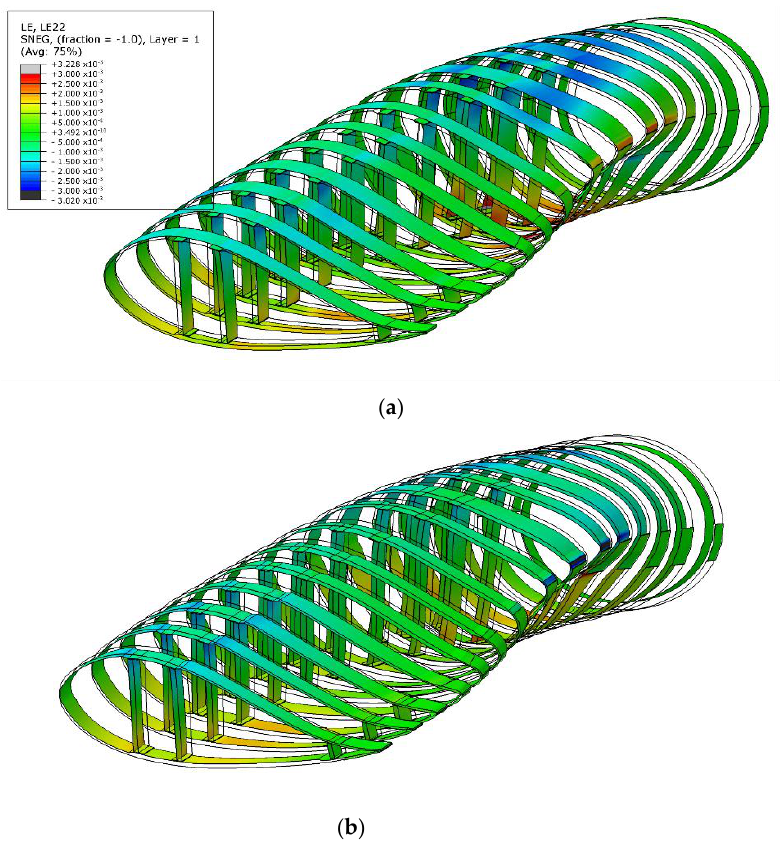
Figure 16. Contour plots of the transverse true strain values on a series of cross-sections of the solid model, deformed under the negative flatwise load case. The deformation is scaled by a factor 20 for clarity. ( a ) Strain values on the outside surface; ( b ) strain values on the inside surface.